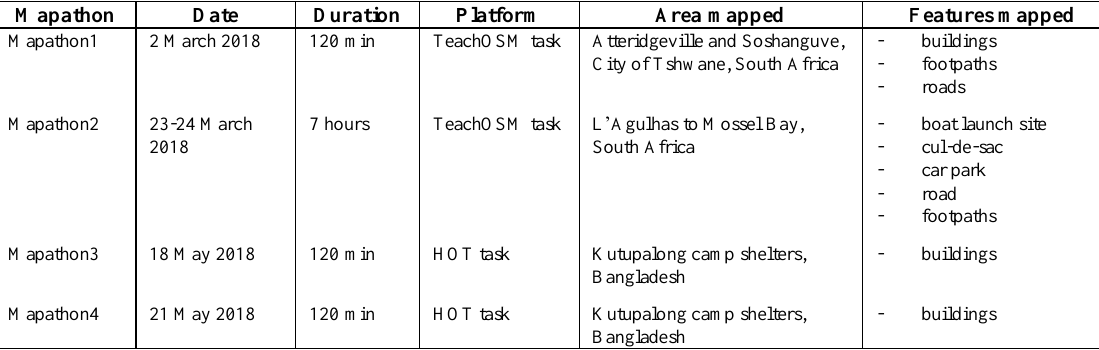
Table 1. Overview of the four mapathons evaluated